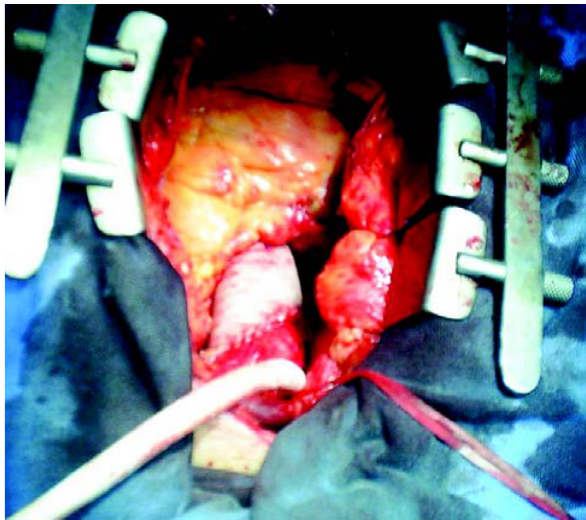
Fig. 2 -Toracotomia mediana com esternotomia, dissecção e